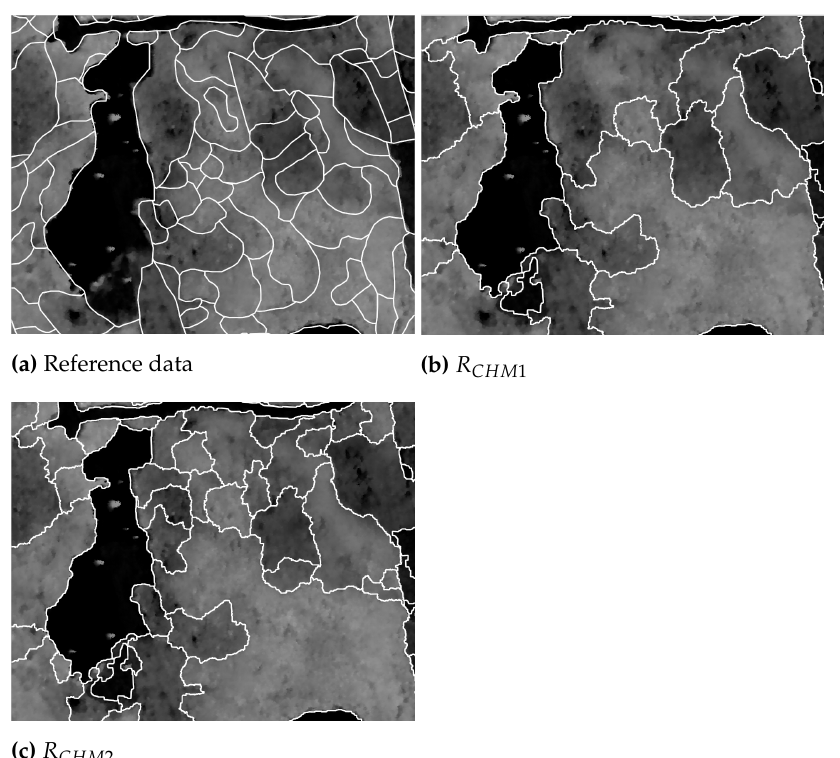
Figure 5. Example of CHM segmentation using JSEG workflow without adding the multispectral information (56.51 ◦ N, 24.96 ◦ E: 56.51 ◦ N, 24.97 ◦ E). a) Reference data delineated by the image analyst, b) R CHM 1 (see section 2.3.1) segmentation results, c) R CHM 2 (see section 2.3.1) segmentation results.